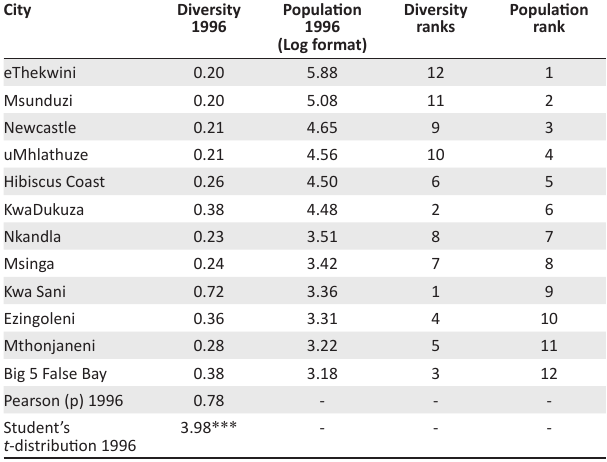
TABLE 5: Most and least specialised and diversified KwaZulu-Natal cities. City